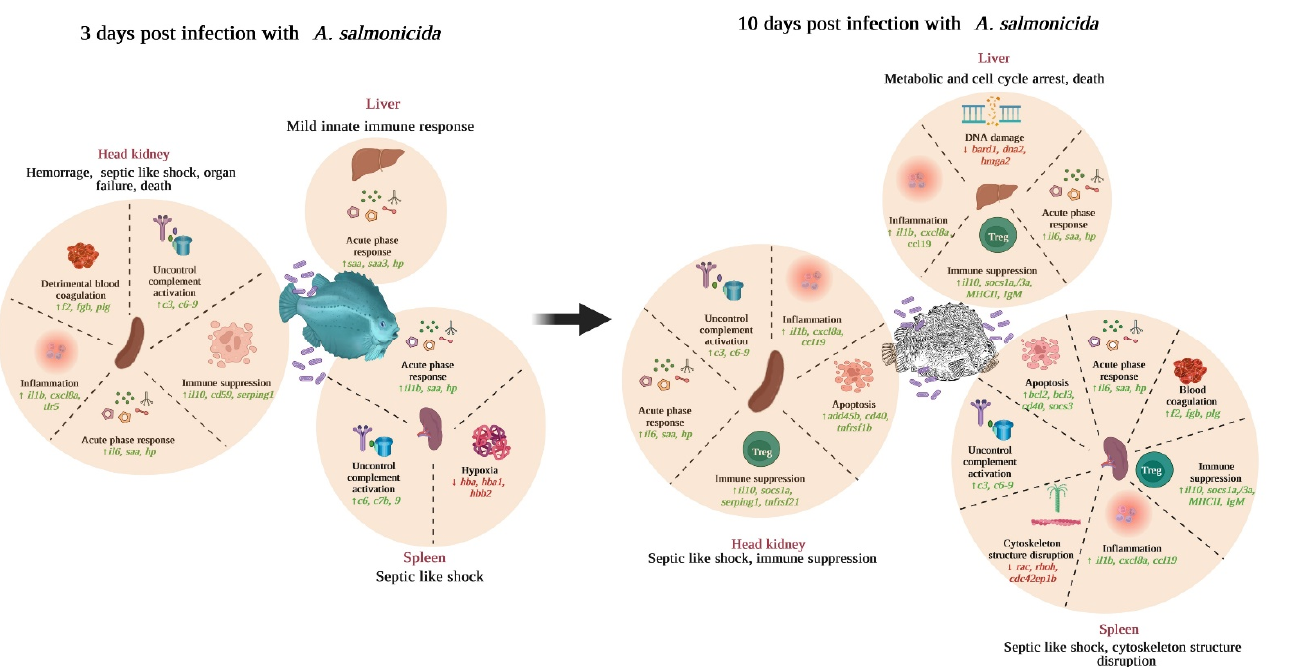
ure S5. Transcript expression profile comparison. Figure S6. Correlation analysis, and hierarchical clustering. Figure S7. ClueGO-based enriched gene ontology (GO) terms in lumpfish lymphoid or- gans at 3 dpi with A. salmonicida . Figure S8. ClueGO-based enriched gene ontology (GO) terms in lumpfish lymphoid organs at 10 dpi with A. salmonicida . Figure S9. Gene expression correlation between RT-qPCR and RNA-Seq data of 14 gene expressions. Figure S10. Aeromonas salmonicida J223 infected lumpfish. Table S1. Quality of the RNA. Table S2. Trimming and mapping statistics. Table S3. Trinity statistics. Table S4. Alignment statistics. Table S5. Primers used in this study. File S1a. Differentially expressed genes (DEGs) in head-kidney 3 dpi identified by reference genome-guided transcriptome assembly (log 2 FC ≥